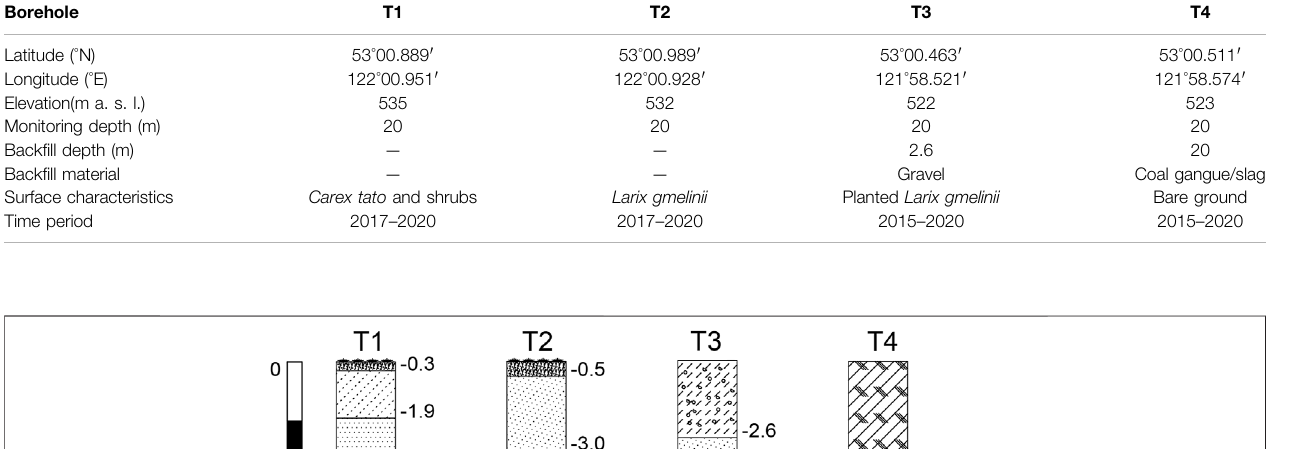
TABLE 1 | Detailed information of four boreholes for ground temperature measurements at the back fi lled and undisturbed areas in the Gulianhe strip coalmine in the Hola Basin in the northern Da Xing ’ anling Mountains in Northeast China. Borehole T1 T2 T3 T4 Latitude ( ° N) Elevation(m a. s. l.)